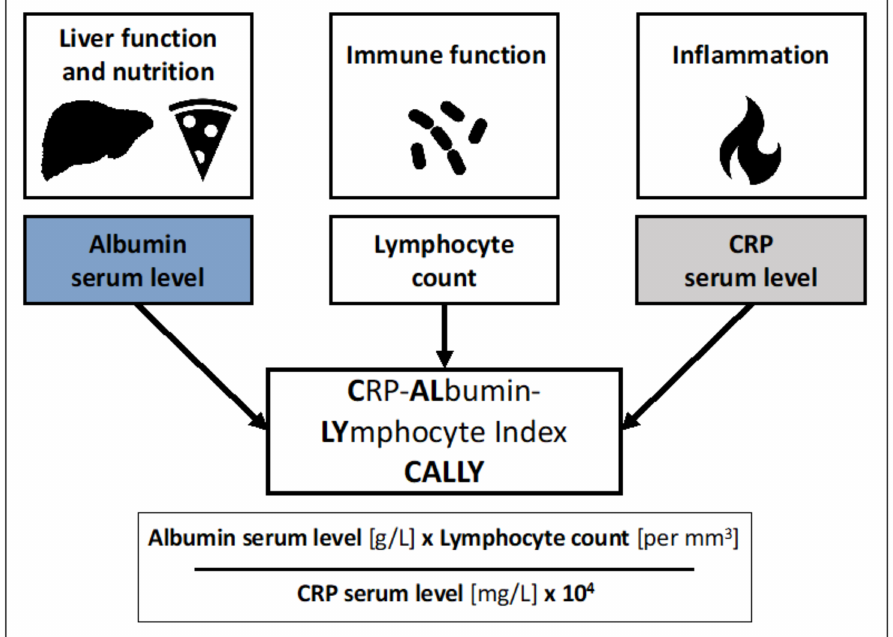
Figure 2. Overview of the formula for calculating the CRP–albumin–lymphocyte (CALLY)